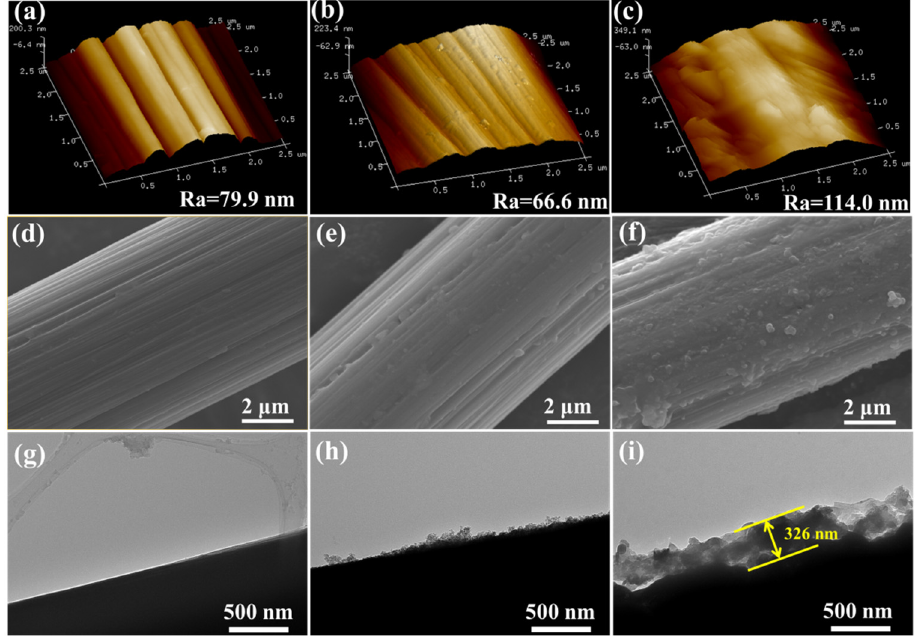
Figure 2. SEM, TEM and AFM images of CF surface topography for: ( a , d , g ) Unmodified CF; ( b , e , h ) CF-PEI and ( c , f , i )